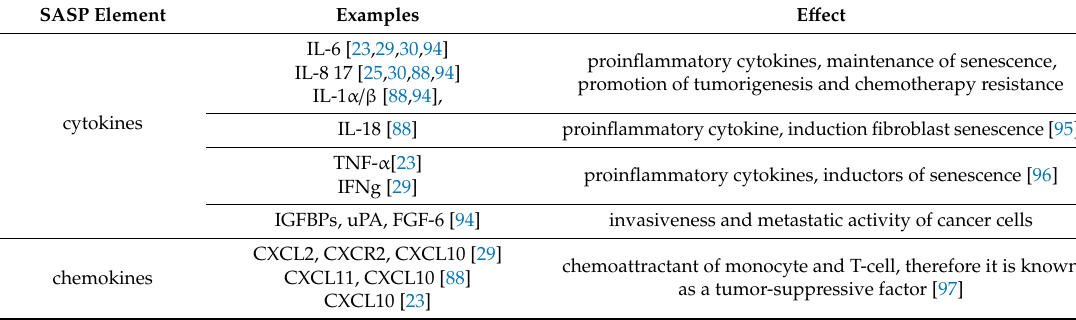
Table 5. SASP in doxorubicin-treated senescent